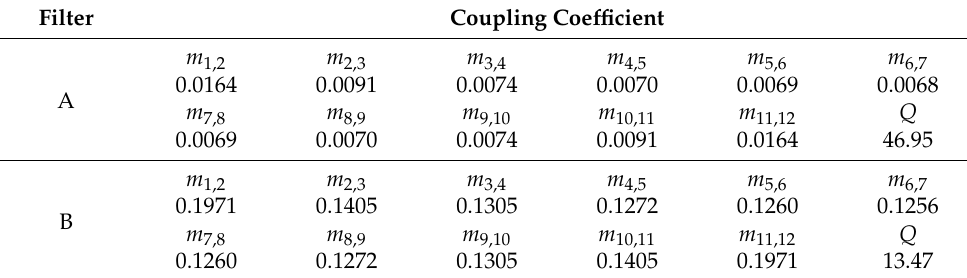
Table 2. The coupling coefficient of the